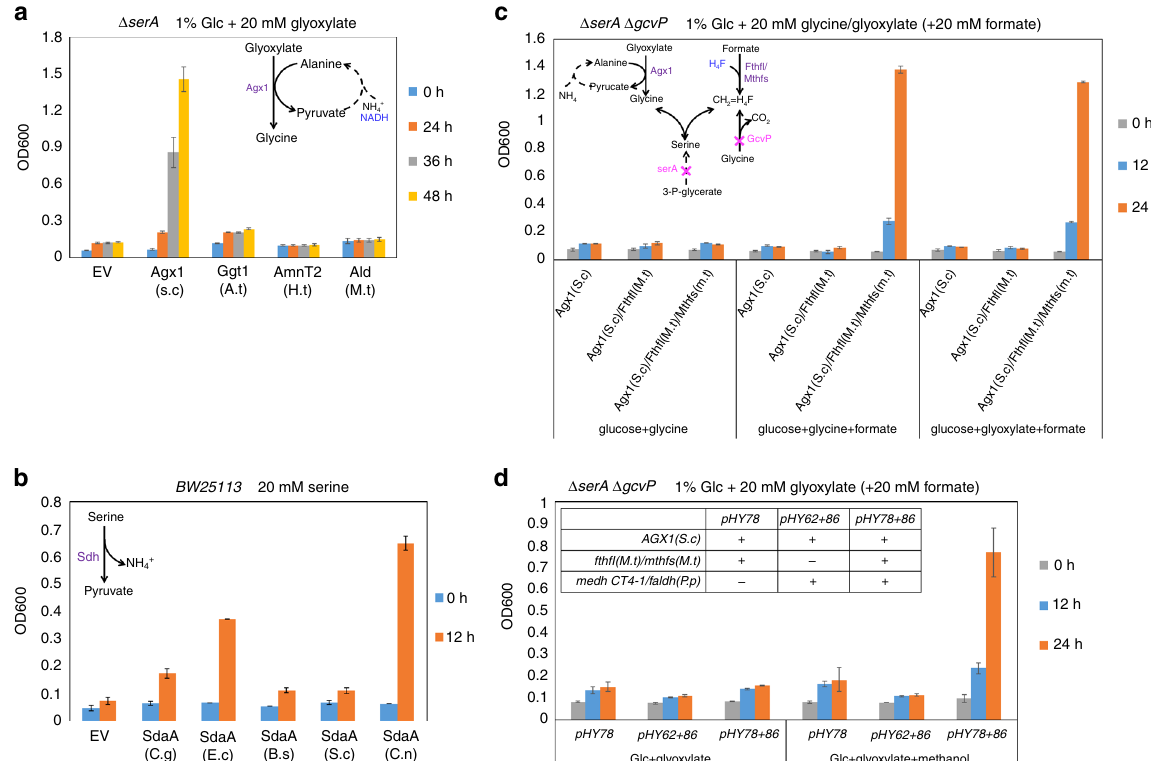
Fig. 2 Determination of the suitable enzymes to establish the modi fi ed serine cycle in E. coli . a Expression of AGX1 ( S.c ) allowed the Δ serA strain to grow in minimal medium with glucose and glyoxylate as carbon sources, suggesting Agx1( S.c ) utilized alanine as an amino donor to convert glyoxylate to glycine and thus rescued the Δ serA strain. Glc glucose. b Expression of sdaA ( C.n ) enabled E. coli wt strain to rapidly grow in minimal medium with serine as the